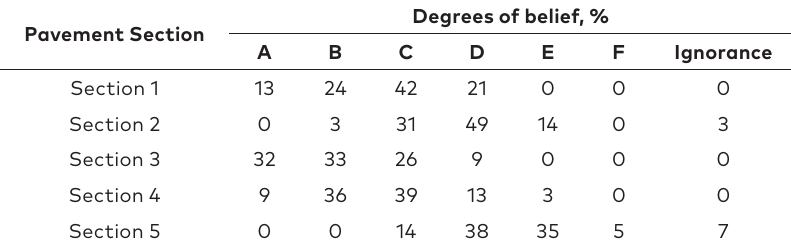
Table 8. Aggregated distributed assessments in